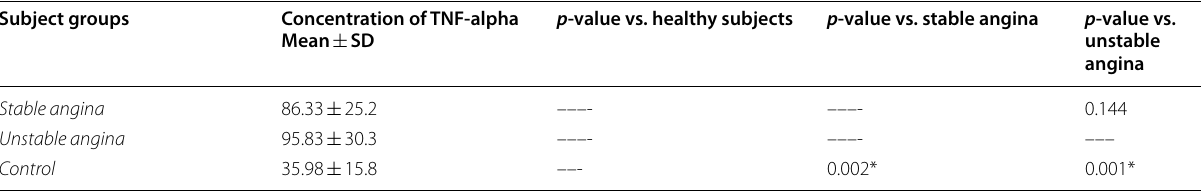
* Significant value when P